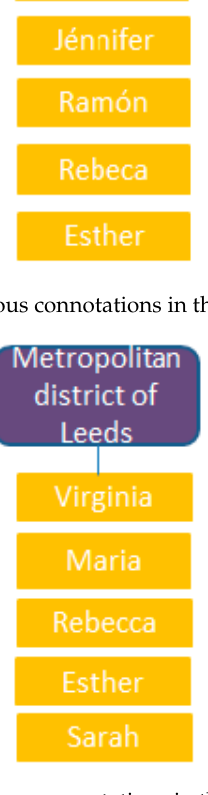
Figure 2. Forenames bearing religious connotations in the metropolitan district of Leeds.